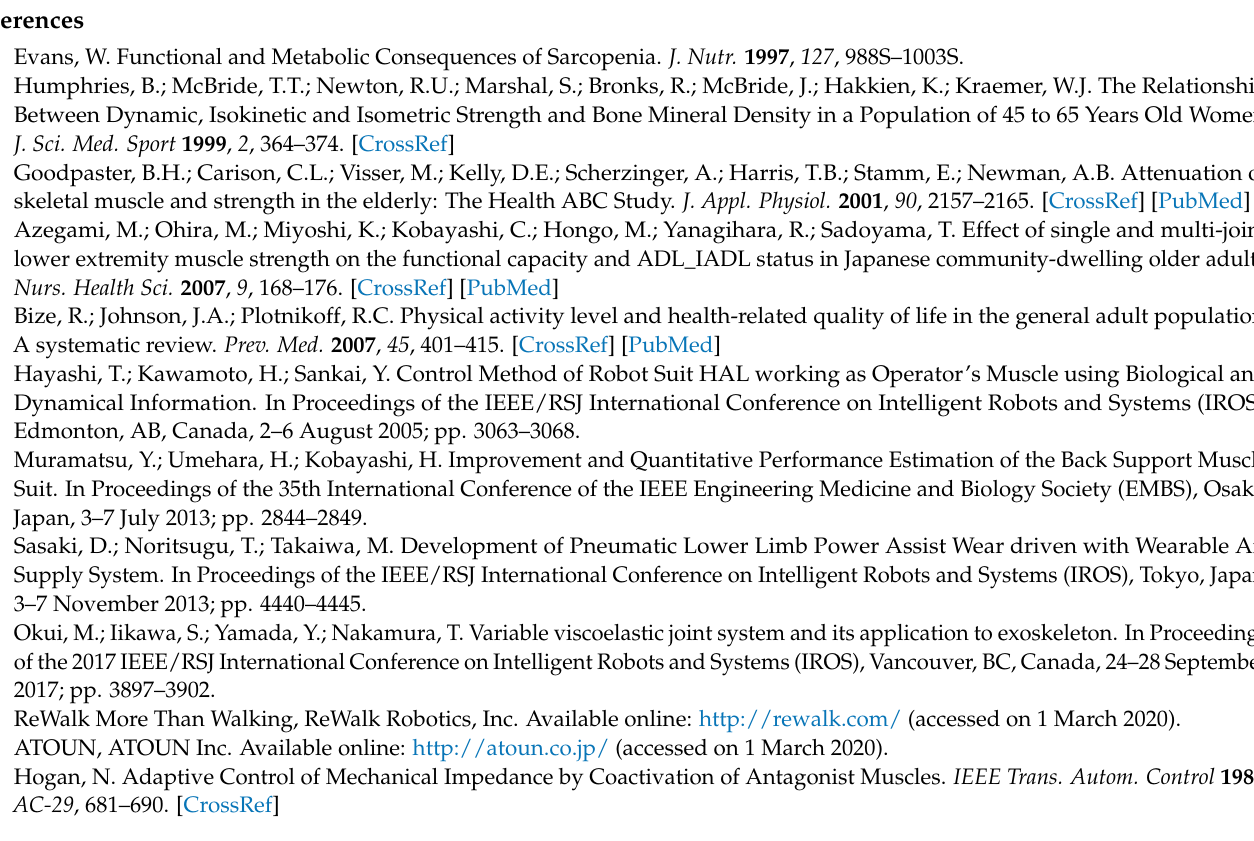
Figure A1. Comparison of EMG with and without assistance and applied pressure to the prototype in one gait cycle (3.0 km/h and 4.5 km/h).